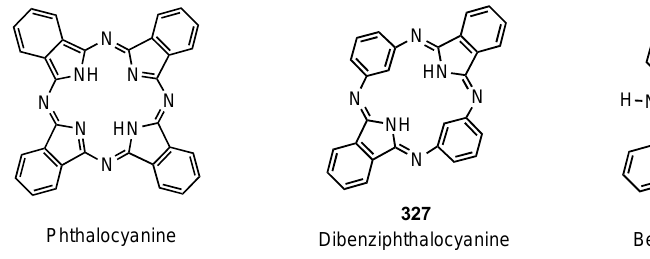
Figure 8. Phthalocyanine analogues.